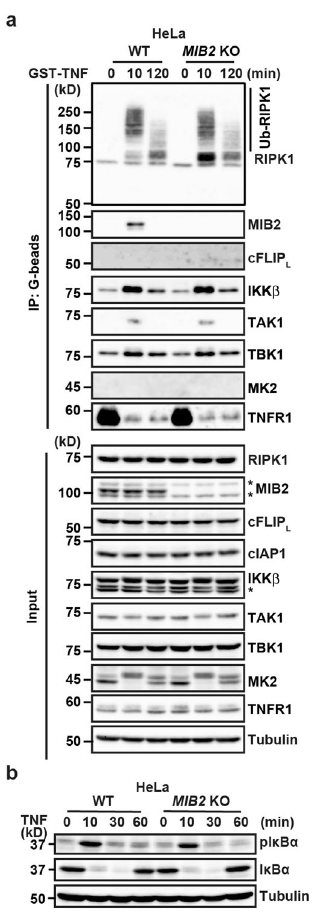
Fig. 5 TNF-induced complex I formation is not altered in WT and MIB2 KO cells. a WT and MIB2 KO HeLa cells were stimulated with GST-TNF (1 μ g/ml) for the indicated times, and TNFR-containing complex I was precipitated with glutathione-Sepharose. Precipitated proteins were analysed by immunoblotting with the indicated antibodies. Protein expression was veri fi ed by immunoblotting with the indicated antibodies. b WT and MIB2 KO HeLa cells were stimulated with TNF (10 ng/ml) for the indicated times, and cell lysates analysed by immunoblotting with the indicated antibodies. Asterisks indicate cross-reacted bands. All results are representative of two or three independent